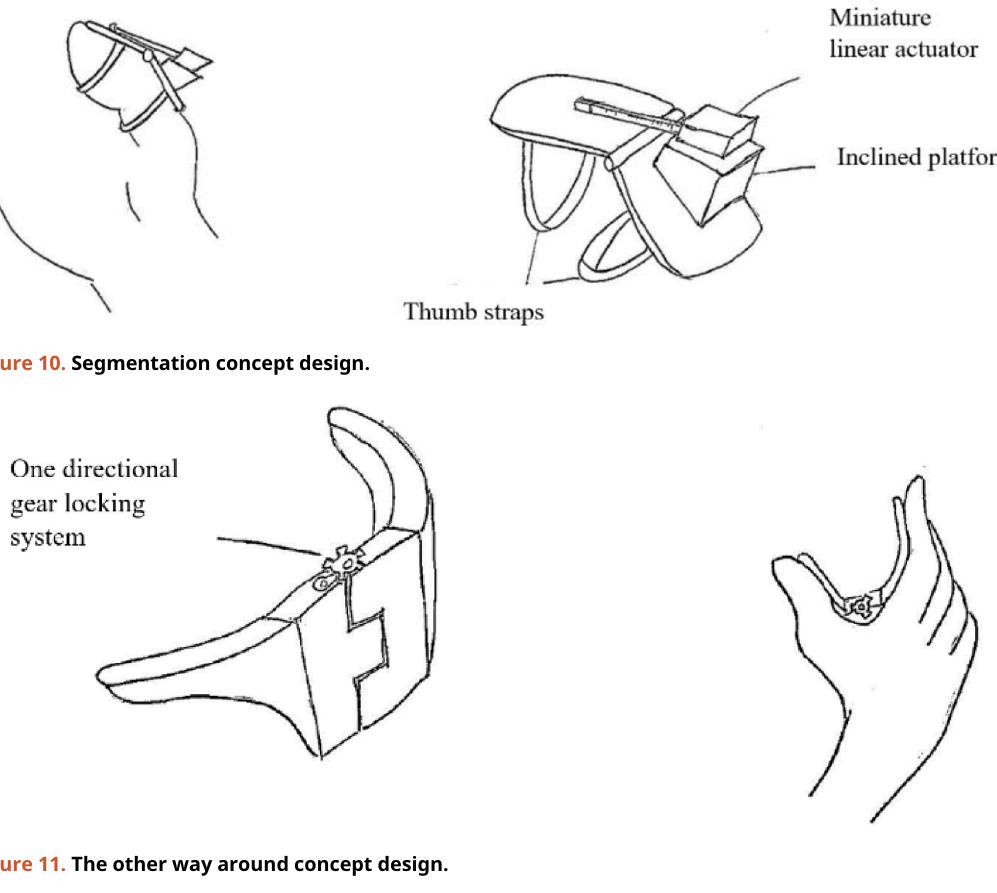
Figure 11. The other way around concept